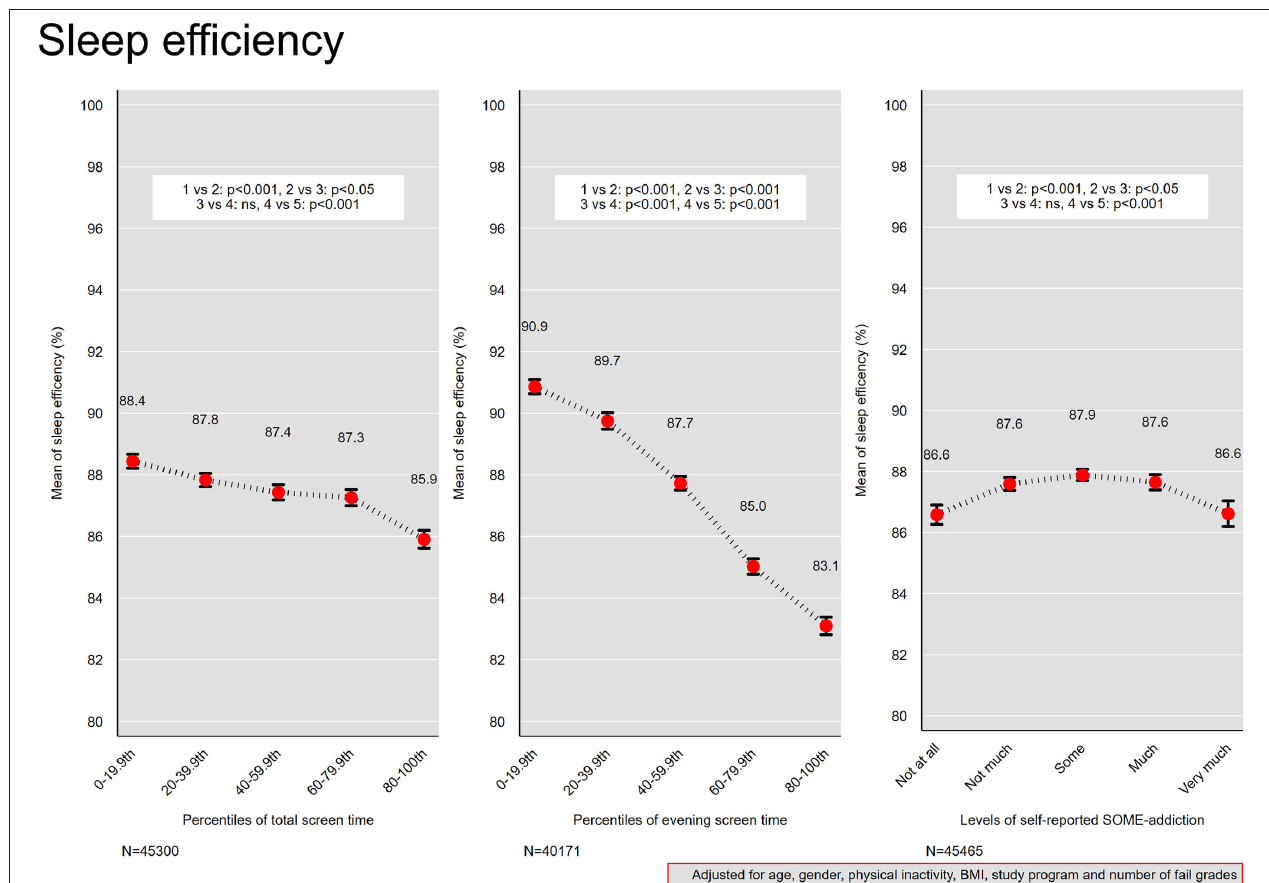
FIGURE 4 | Sleep efficiency. Mean sleep efficiency across quintiles of total screen time and evening screen time, and levels of self-reported social media addiction. Results from linear regression models adjusted for age, gender, physical activity, and body mass index. Bars denote 95 % confidence